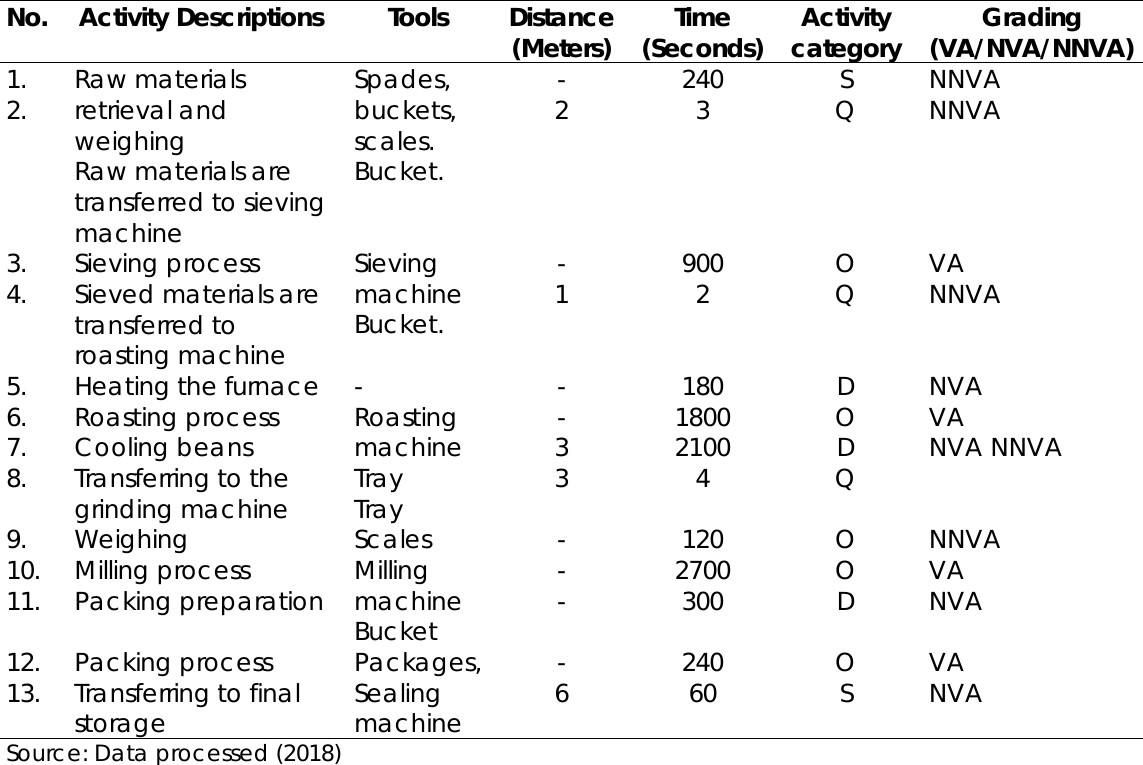
Process Activity Mapping (Current